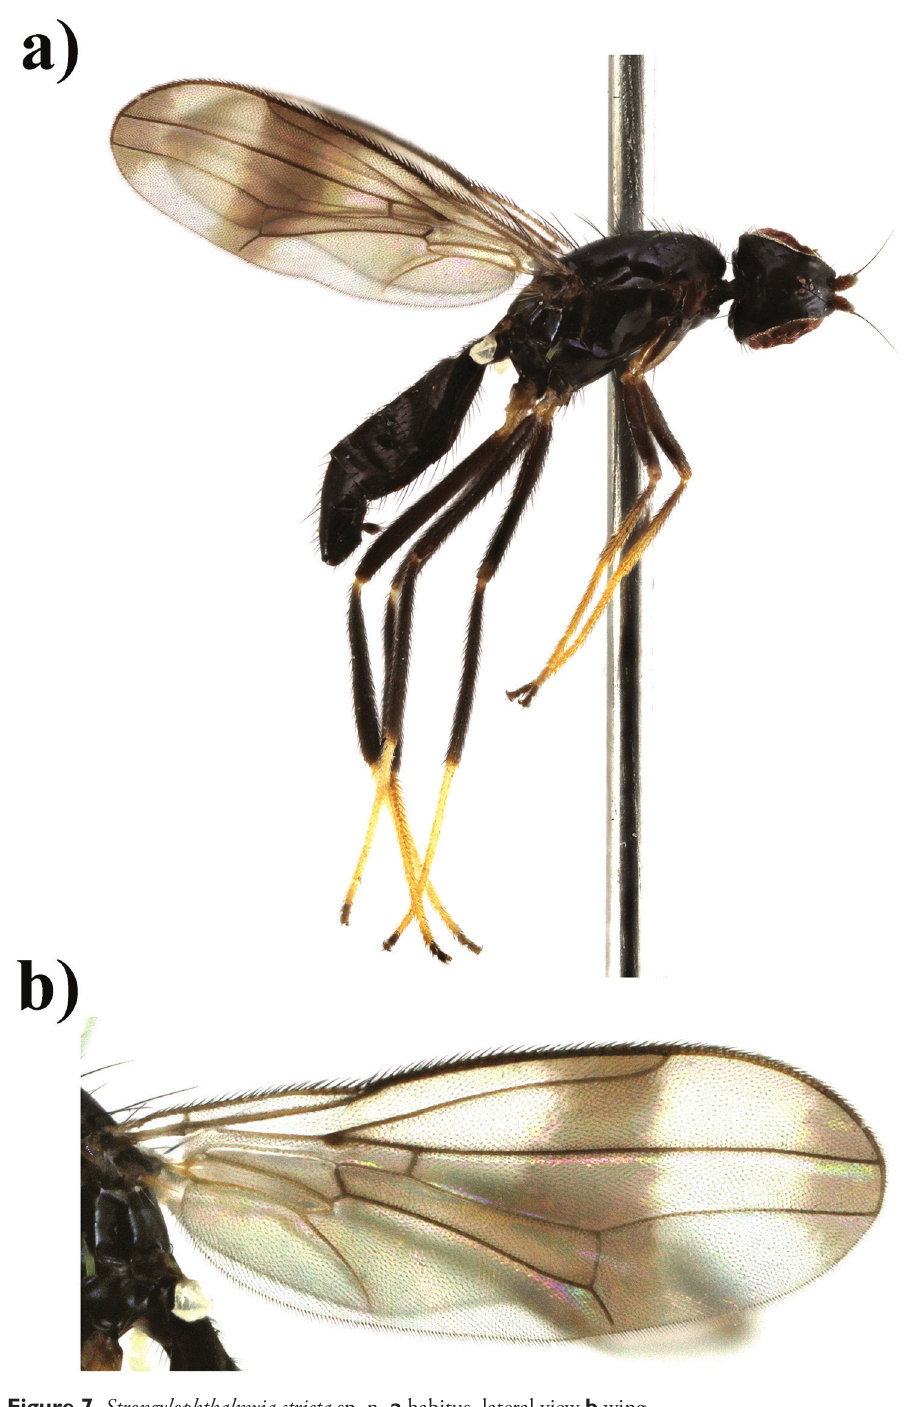
Figure 7. Strongylophthalmyia stricta sp. n. a habitus, lateral view b